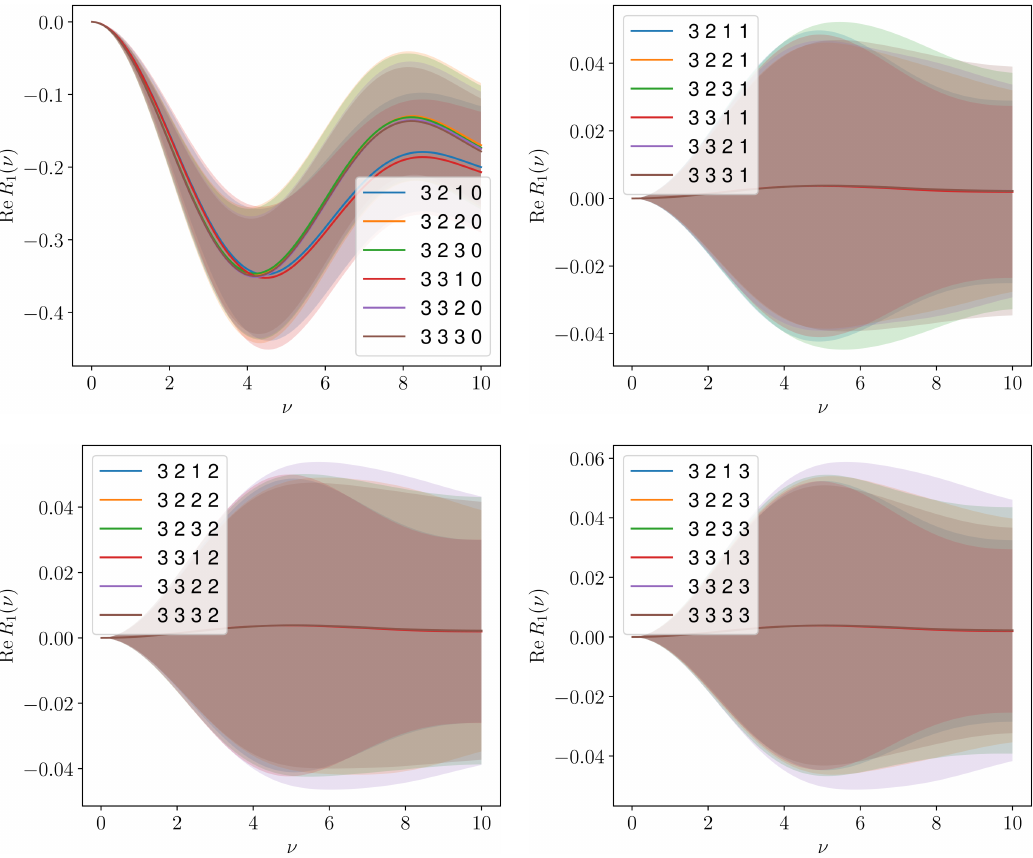
Figure 25 . The higher twist term, B 1 , results from fitting the real component to the models. The numbers in the legend correspond to ( N ± , N